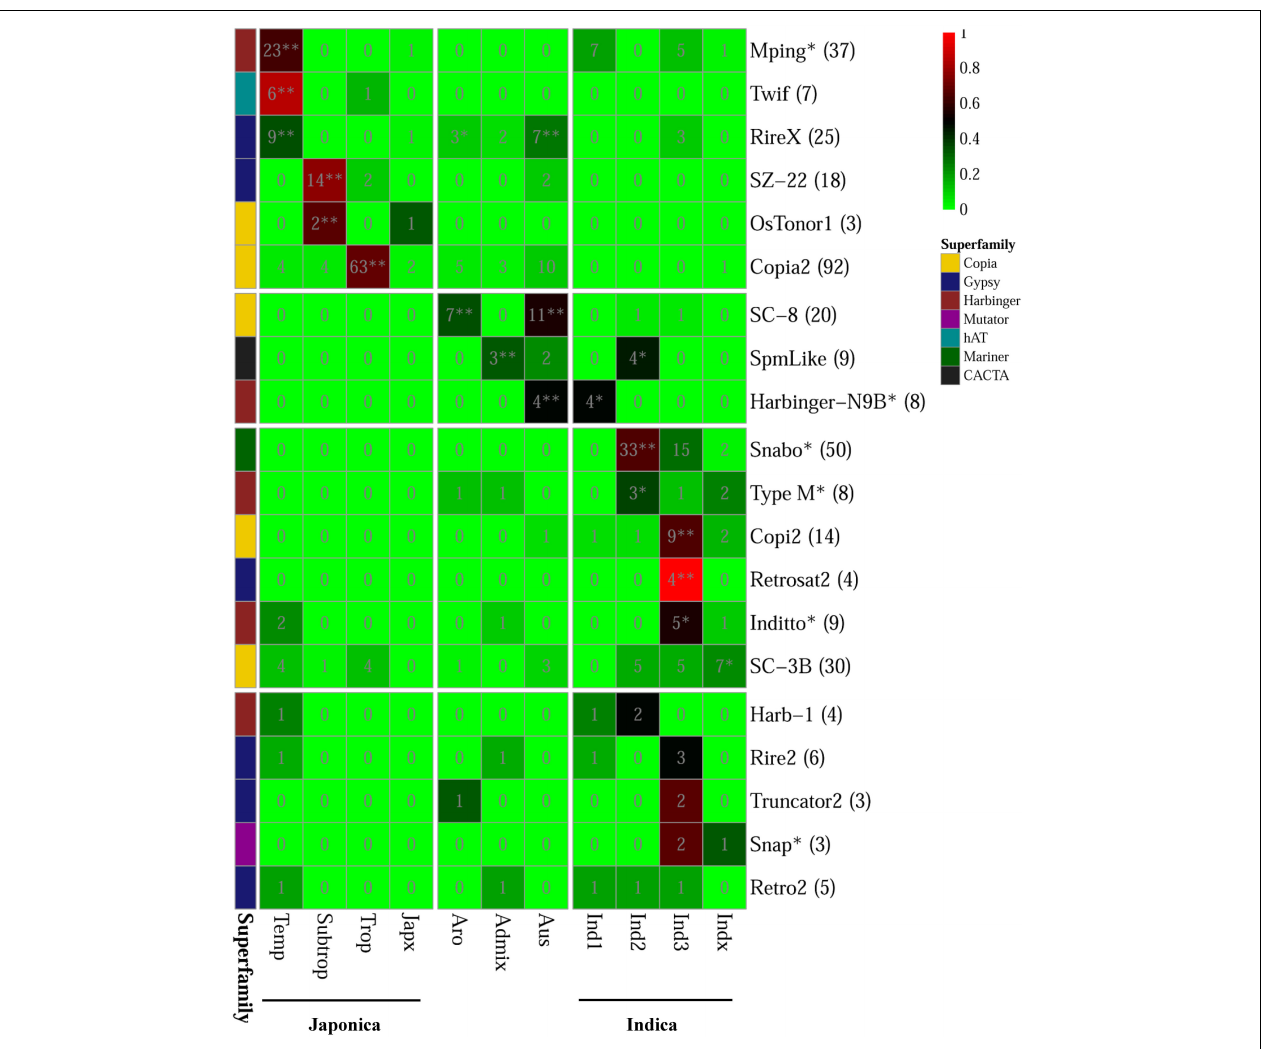
FIGURE 5 | Distribution of rice accessions carrying PHA TE among different variety groups/subgroups. The numbers in parentheses represented the total number of rice accessions carrying the corresponding highly active TE in 3,000 natural rice accessions. The asterisk appended to the name of TE family denoted that the corresponding family was also annotated as MITE. The background color displayed in the cell represented the ratio of the number of rice accessions carrying the corresponding highly active TE in the variety group to total number of rice accessions carrying the corresponding highly active TE in 3,000 natural rice accessions. In addition, the asterisk and double asterisks in the cells represented significant and extremely significant level in the Fisher’s exact test for the enrichment analysis,